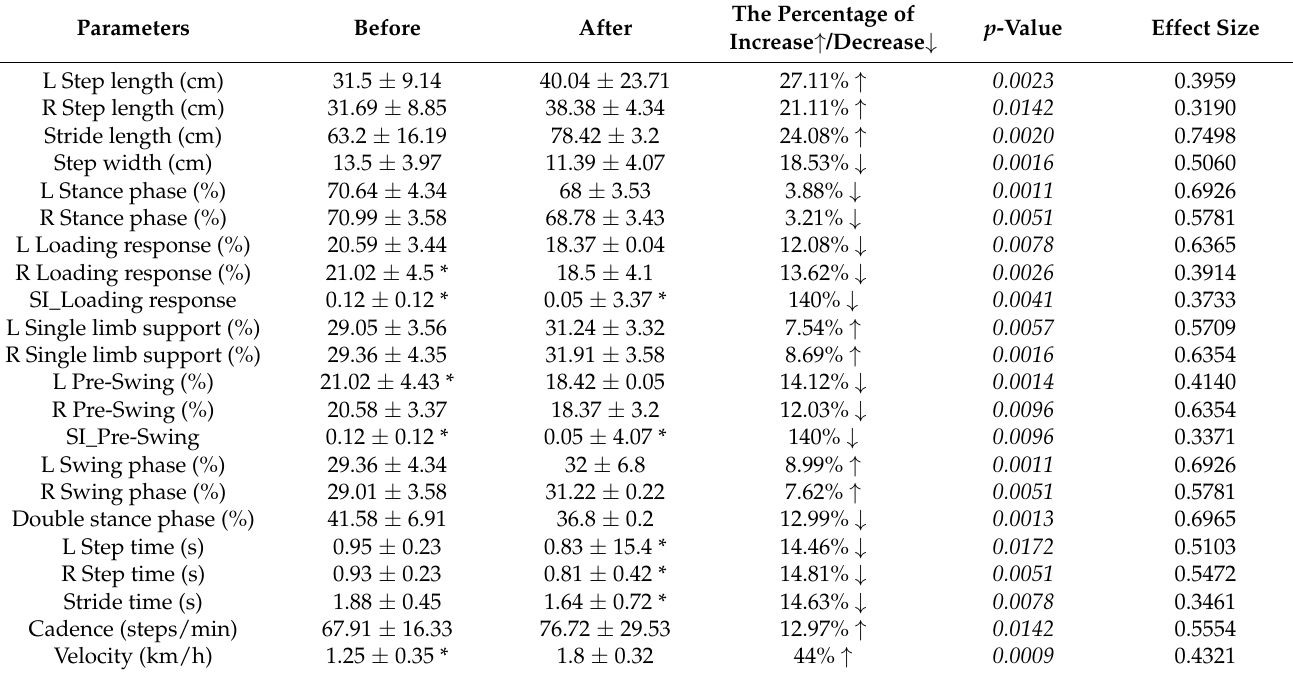
Table 7. Results (mean ± SD) of Wilcoxon test/ t -test ( p < 0.05) and effect size for comparison before and after rehabilitation within the control group for spatiotemporal